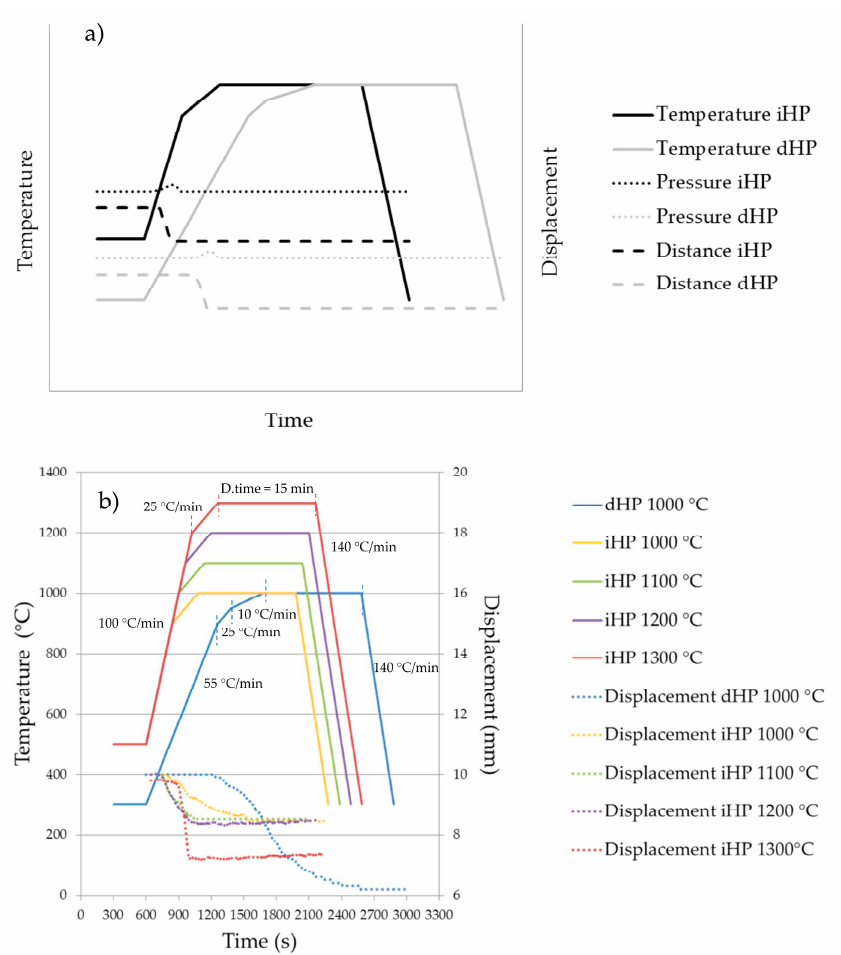
Figure 1. ( a ) Graphical representation of temperature vs. time in iHP and dHP cycles; ( b ) temperature variations vs. time and shrinkage displacements vs. time for TMCs processing cycles from the same starting powders.